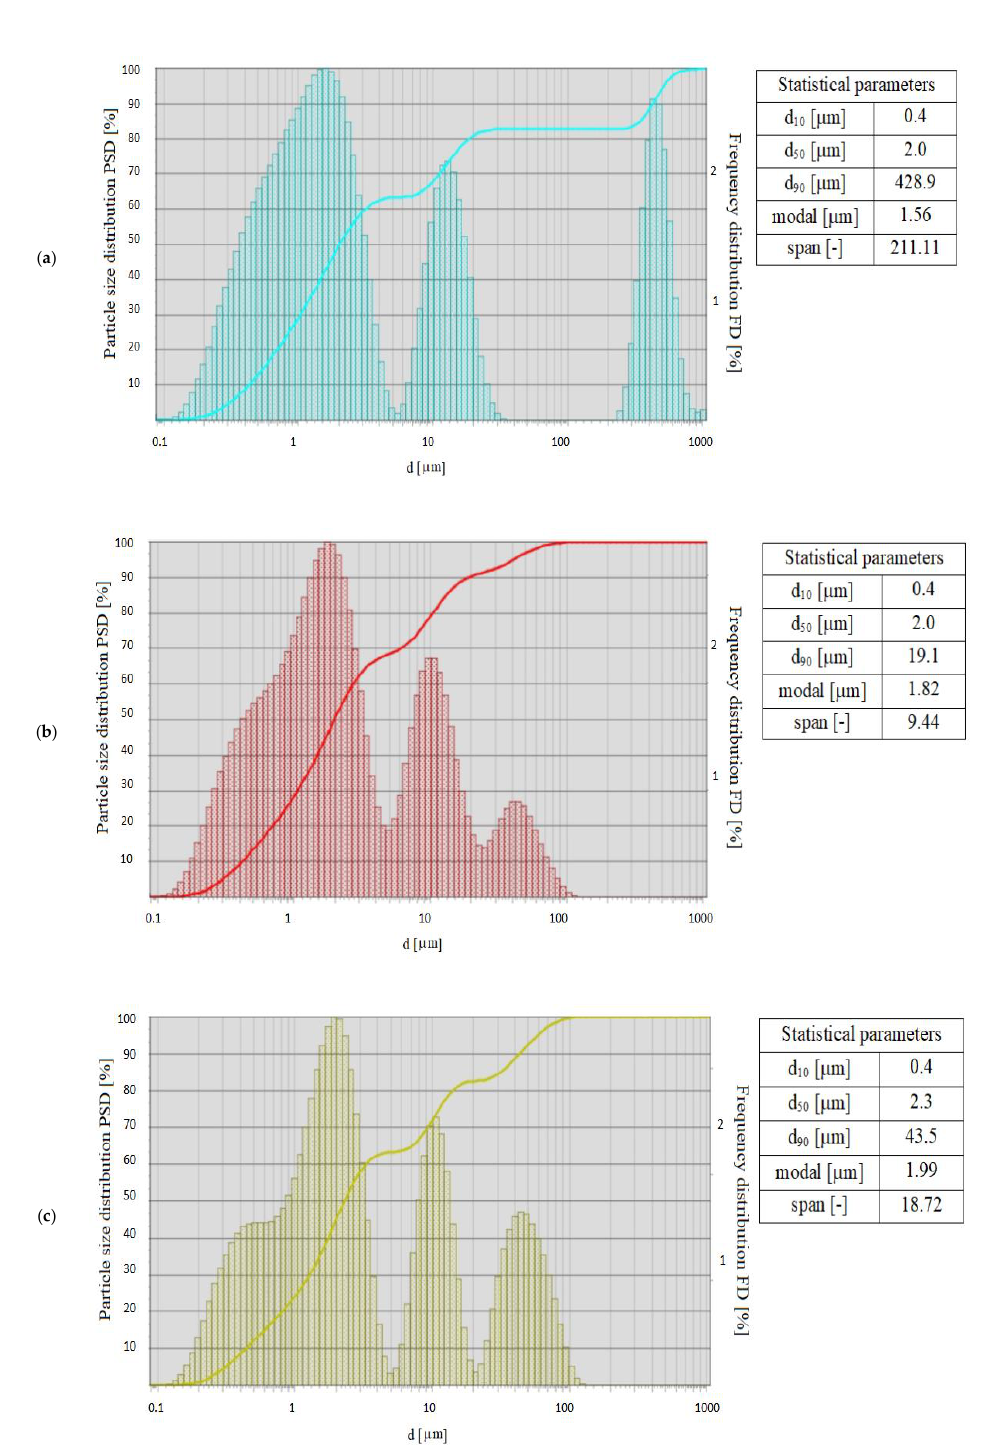
Figure 7. Sizes of characteristic particles determined with the use of the laser diffraction method in Table 1: ( a ) 1st measurement, ( b ) 2nd measurement, ( c ) 3rd measurement.